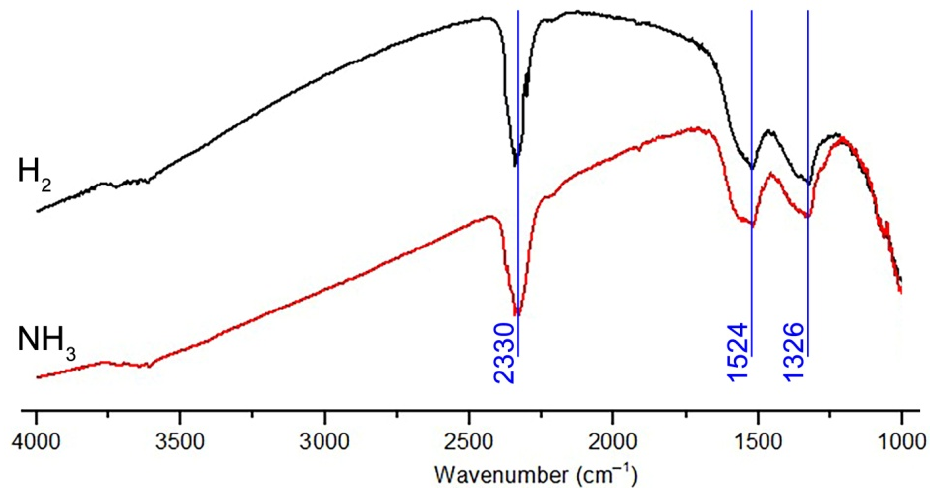
Figure 10. DRIFT spectra of ZnO/Pd nanofibers recorded after 120 min of exposure in the presence of 500 ppm H 2 and 500 ppm NH 3 in background gas with 0.0005% O 2 at 350 °C.